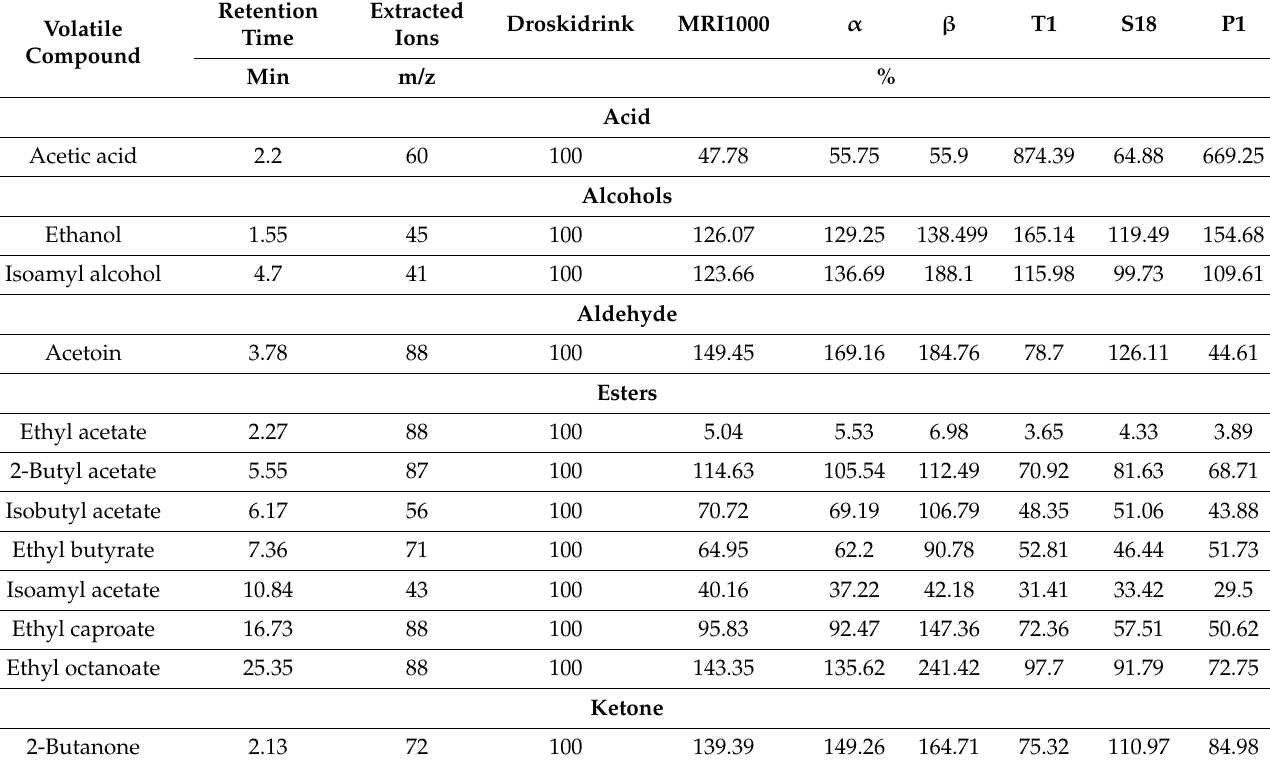
Table 2. Relative quantification of volatiles emitted by baits inoculated with different strains of Oenococcus oeni (MRI1000, alpha, beta, T1, S18, P1). Data are expressed as the percentage (%) with respect to the amount measured in the standard, unfermented